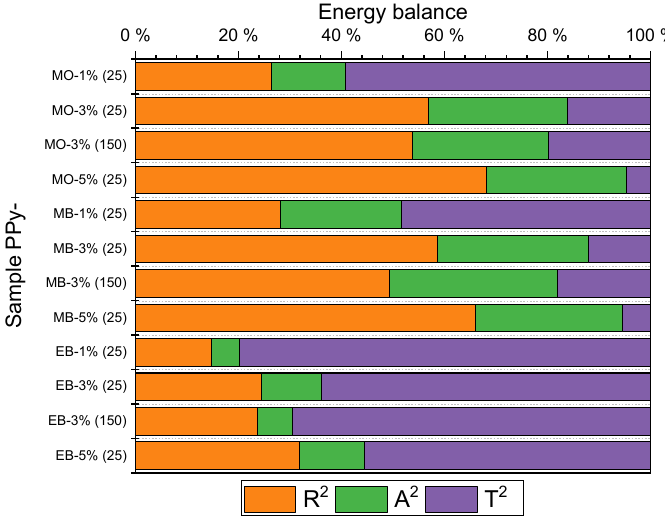
Figure 6. RAT (reflection, transmission, absorption) analysis of PPy 1D samples (sample curing at 25 and 150 °C, various loadings 1, 3 and 5% w / w ).